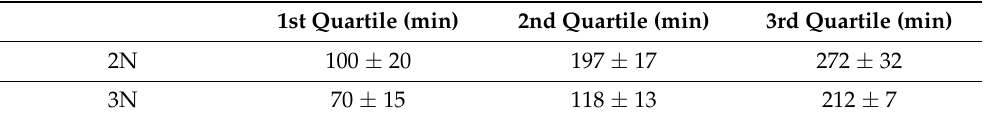
Table 2. Endurance (mean ± SEM) of the 1st, 2nd and 3rd 2N and 3N quartiles of Blackwater rainbow trout ( Oncorhynchus mykiss ) to fail during endurance swimming tests in 2008 (n = 500 in each of two endurance